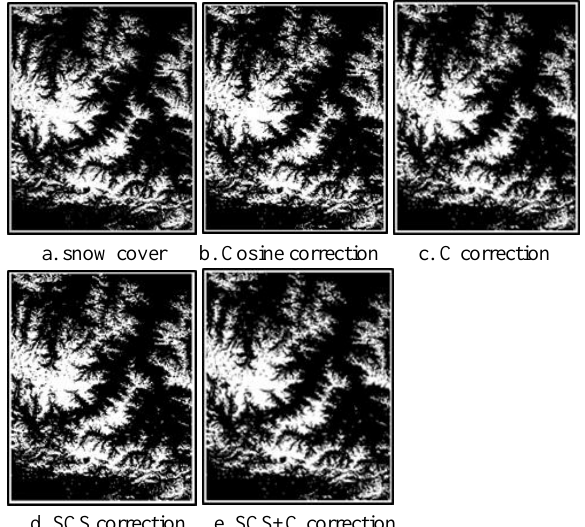
Figure 8. Snow cover comparison before and after topographic correction